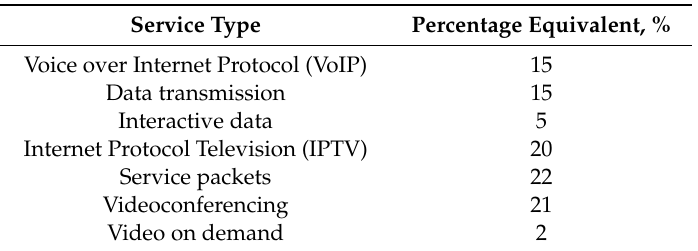
Table 2. Distribution of e-service usage in the